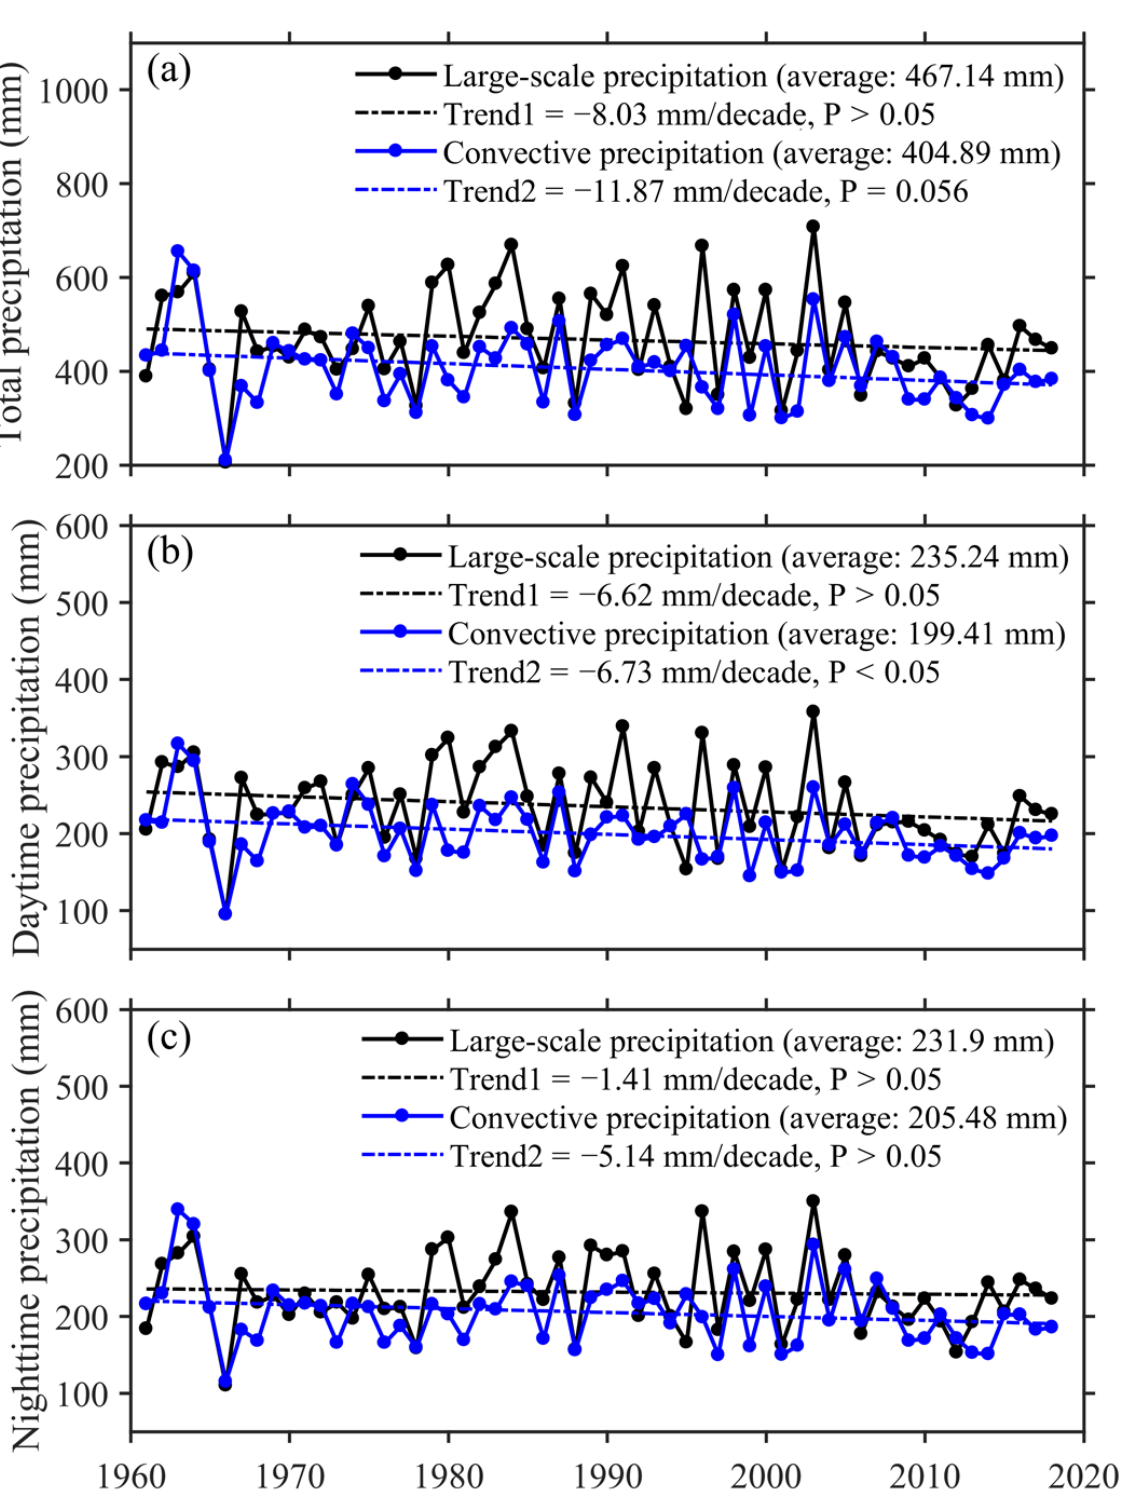
Figure 3. Annual large-scale and convective precipitation of ( a ) total (daily), ( b ) daytime, and ( c ) nighttime precipitation per year averaged over the HRB from 1961 to 2018 in the ERA5CON.